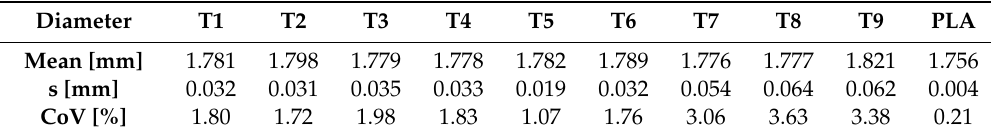
Table 2. Inline determined diameter data of produced filaments and commercial PLA (mean, standard deviation (s) and coe ffi cient of variation (CoV), n = ~300).